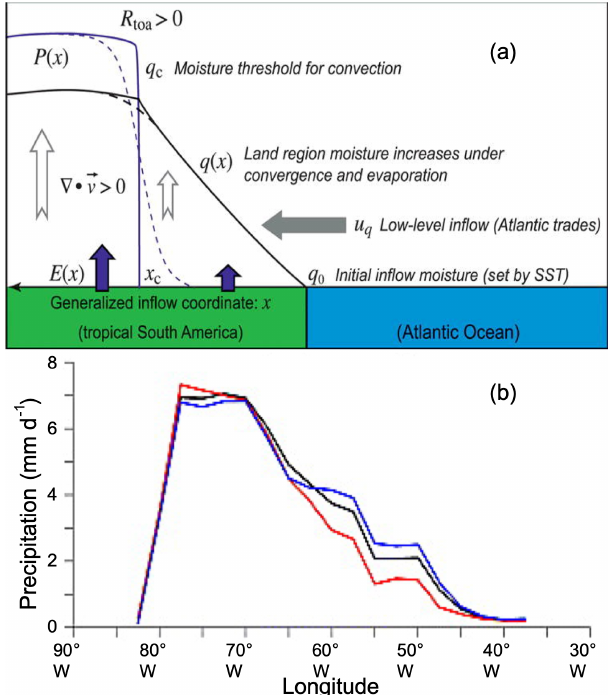
Figure 13. (a) Schematic of the key elements of the convective mar- gins framework as applied along an inflow path across northeast- ern South America. The solid blue and black lines are precipita- tion and vertically integrated moisture for steady-state conditions, while the dashed blue and black lines correspond to precipitation and vertically integrated moisture “smeared out” in the presence of time-varying, transient behavior. Adapted from Fig. 2 of Lintner and Neelin (2009). (b) Rainfall